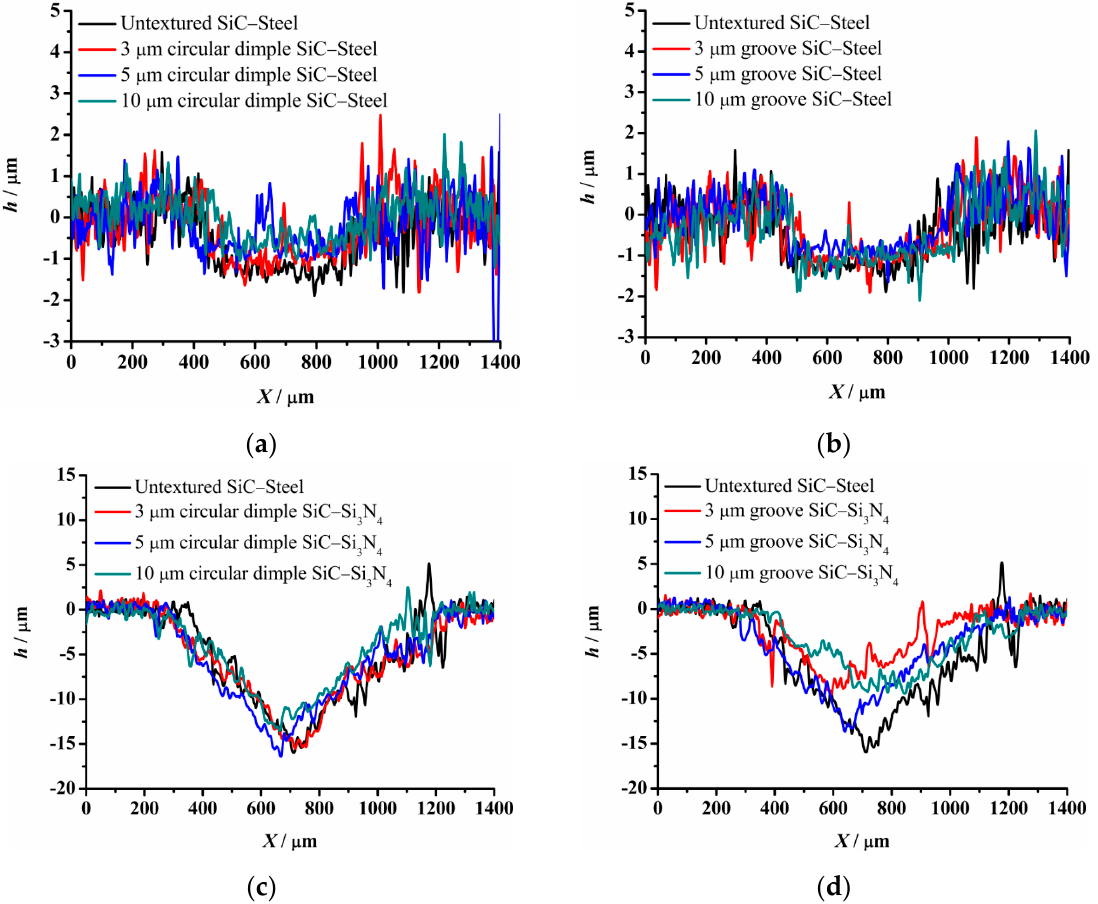
Figure 10. Cross section of wear scars under dry-friction conditions with a load of 30 N: ( a ) circular-dimple-texture SiC–steel ball, ( b ) groove-textured SiC–steel ball, ( c ) circular-dimple-textured SiC–Si3N4 ball, and ( d ) groove-textured SiC–Si3N4 ball.